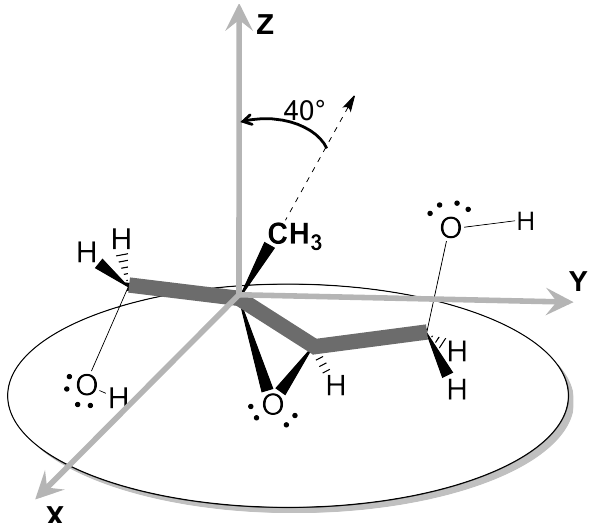
Fig. 5. Proposed model of trans- β -IEPOX (1) molecular orientation on a surface. The surface normal is located along the z axis, with a 40 ◦ methyl tilt angle. The rigid backbone of the molecule due to the epoxide ring is indicated by a thick gray